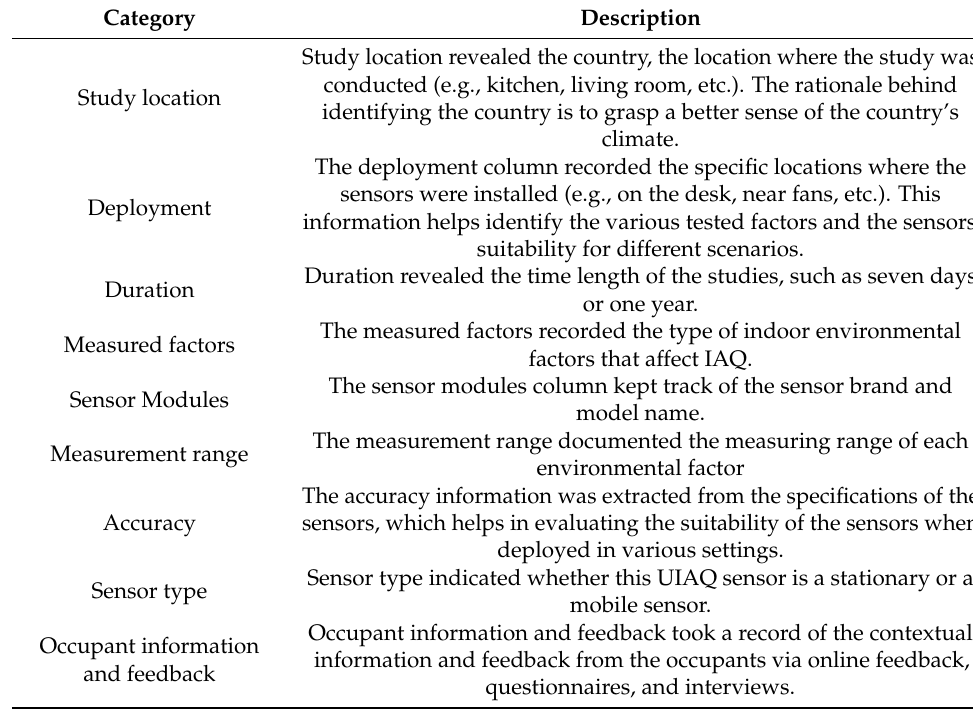
Table 2. Categorization of the selected UIAQS technology-related studies. Category Description Study location revealed the country, the location where the study was conducted (e.g., kitchen, living room, etc.). The rationale behind Study location identifying the country is to grasp a better sense of the country’s climate. The deployment column recorded the specific locations where the sensors were installed (e.g., on the desk, near fans, etc.). This Deployment information helps identify the various tested factors and the sensors’ suitability for different scenarios. Duration revealed the time length of the studies, such as seven days Duration or one year. factors that affect IAQ.